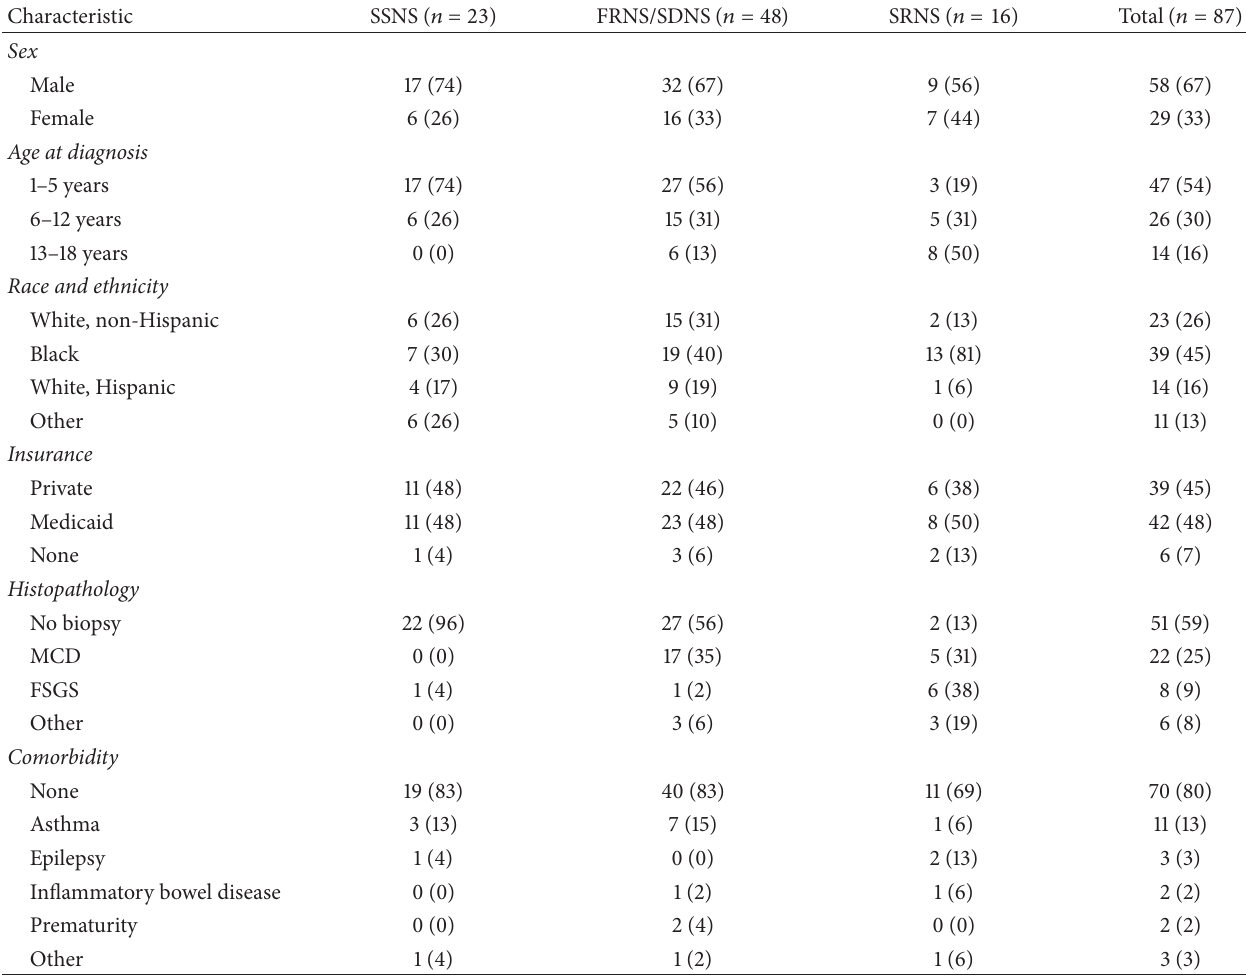
Table 1: Characteristics of patients with childhood nephrotic syndrome diagnosed between 2006 and 2012 in the Atlanta MSA.